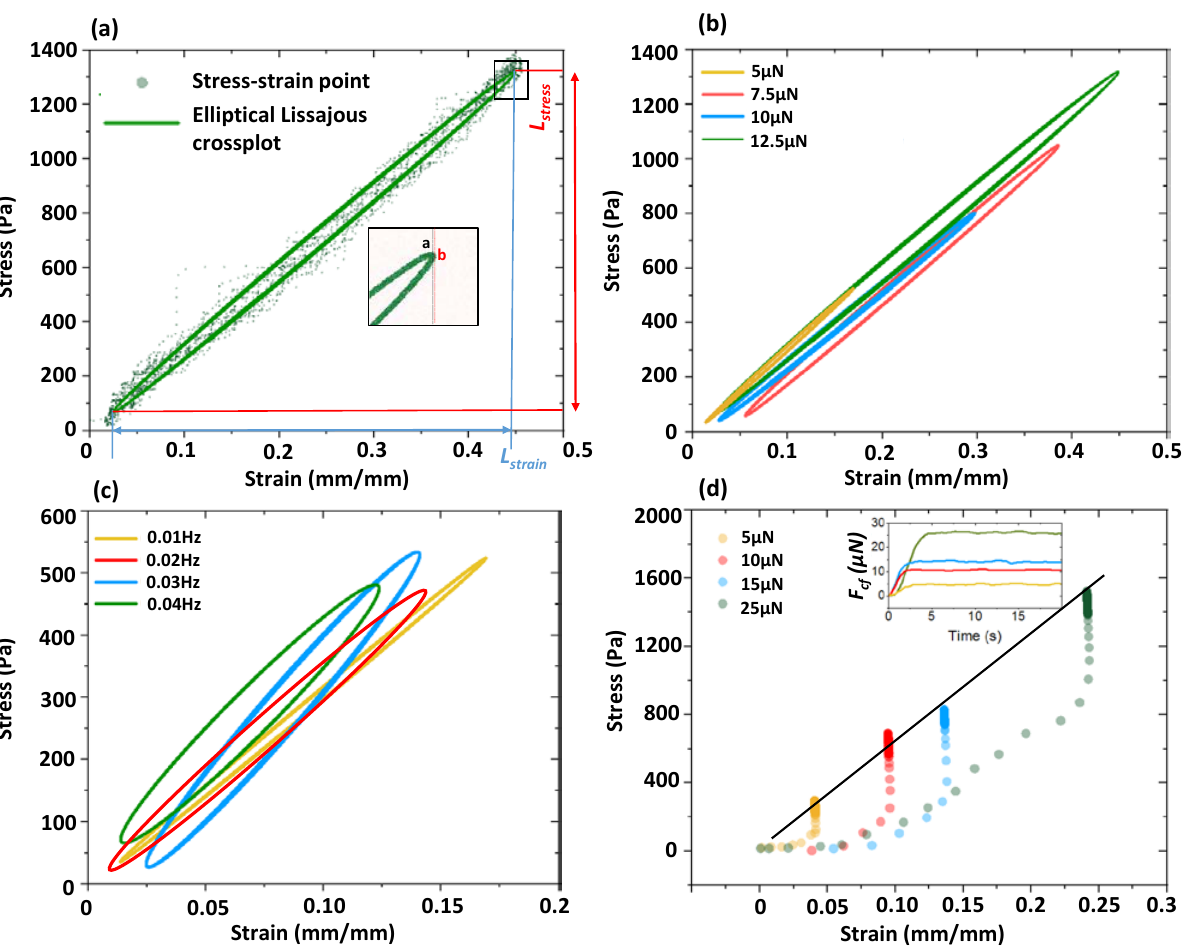
Figure 5. Analysis of stress-strain relationship. ( a ) Scatter plot from the original signals and elliptical Lissajous crossplot from the fitted signals to describe stress-strain loop. ( b ) Elliptical Lissajous cross- plots under different stress amplitudes. ( c ) Elliptical Lissajous crossplots under different frequen- cies. ( d ) Stress-strain curve under different constant force loading. Insert is a time-dependent con- stant force control.